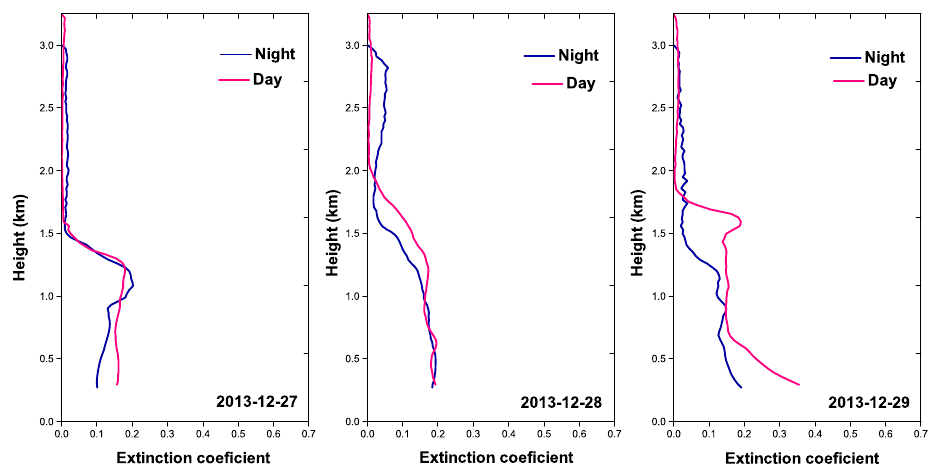
Figure 13. Profiles of aerosol extinction coefficient from MPL-retrieved data averaged for daytime and nighttime during 27–29 December 2013 in